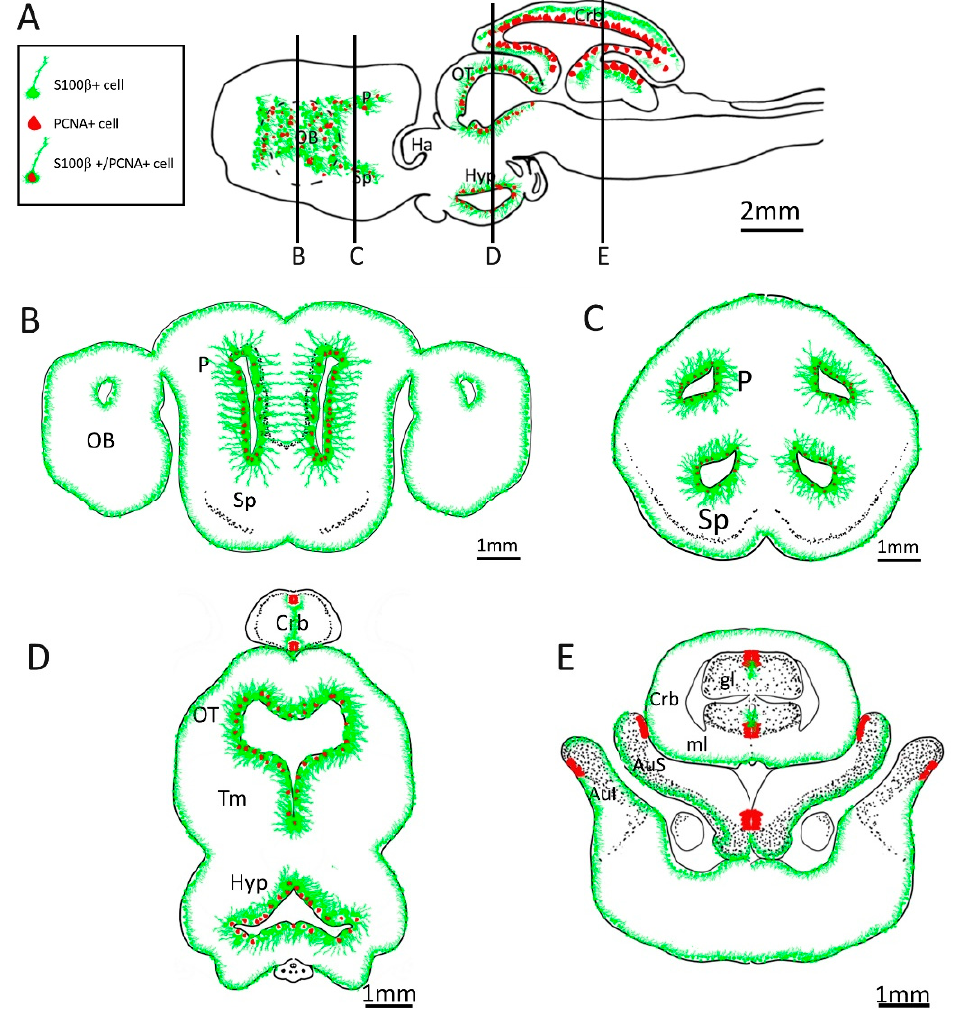
Figure 22. Schematic representation of adult neurogenic niches in Scyliorhinus canicula brain. ( A ) Representation of a sagittal section of S. canicula brain, with indicative localization of S100 β + (green) and PCNA + (red) cells. ( B ) Representation of a coronal section of S. canicula anterior telencephalon, with indicative localization of S100 β + (green) and PCNA + (red) cells around the ventricular walls. ( C ) Rep- resentation of a coronal section of S. canicula posterior telencephalon, with indicative localization of S100 β + (green) and PCNA + (red) cells around the ventricular walls. ( D ) Representation of a mesodi- encephalic coronal section of S. canicula , with indicative localization of S100 β + (green) and PCNA + (red) cells. ( E ) Representation of a posterior coronal section of S. canicula , with indicative localization of S100 β + (green) and PCNA + (red) cells in the cerebellum and cerebellar auricles. Abbreviations: